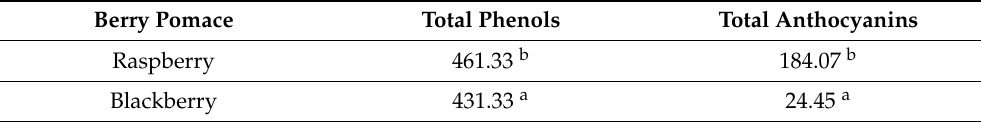
Table 1. Total phenols content and anthocyanins in berry pomace, mg 100 g − 1 GAE and C3GE, DM. Berry Pomace Total Phenols Total Anthocyanins Raspberry 461.33 b 184.07 b Blackberry 431.33 a 24.45 a